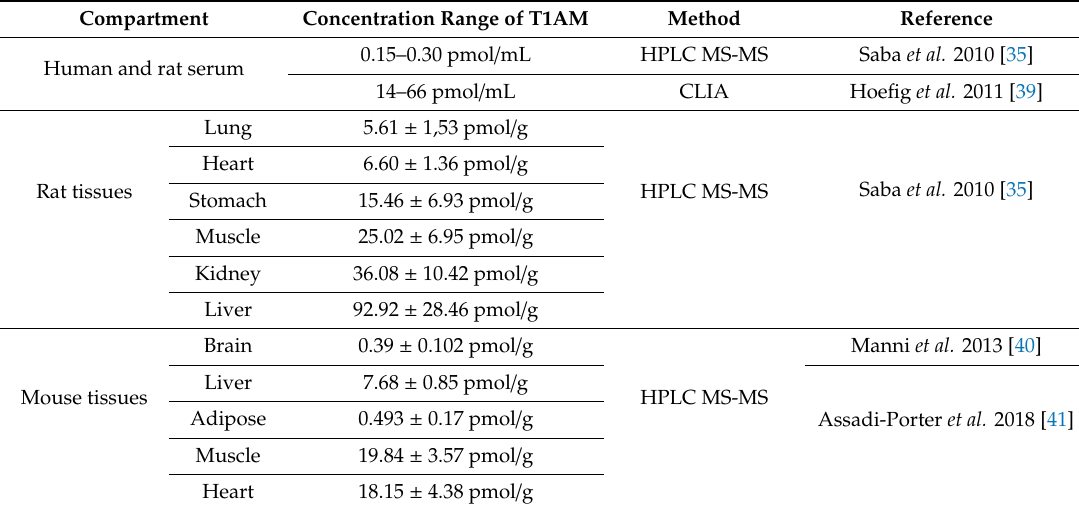
Table 1. 3-Iodothyronamine (T1AM) tissue concentrations in human and